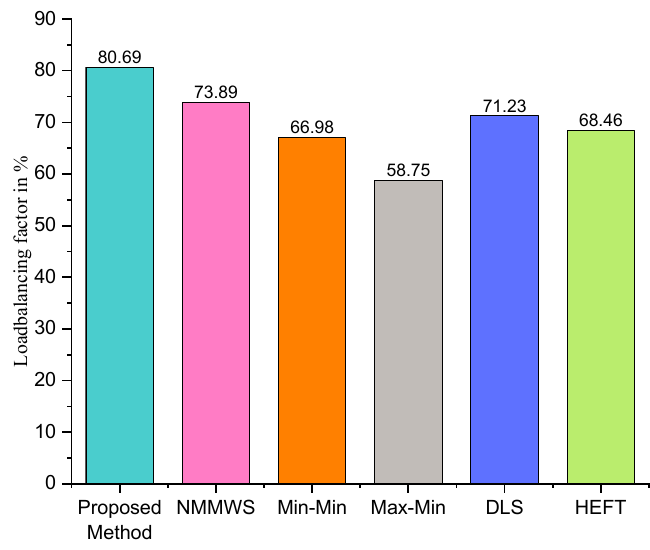
Figure 13. Load balance.